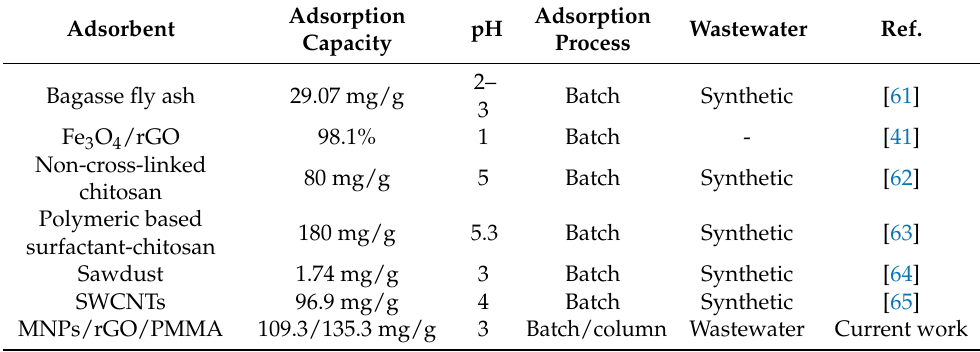
Table 9. Comparison of Cr(VI) adsorption capacities of various